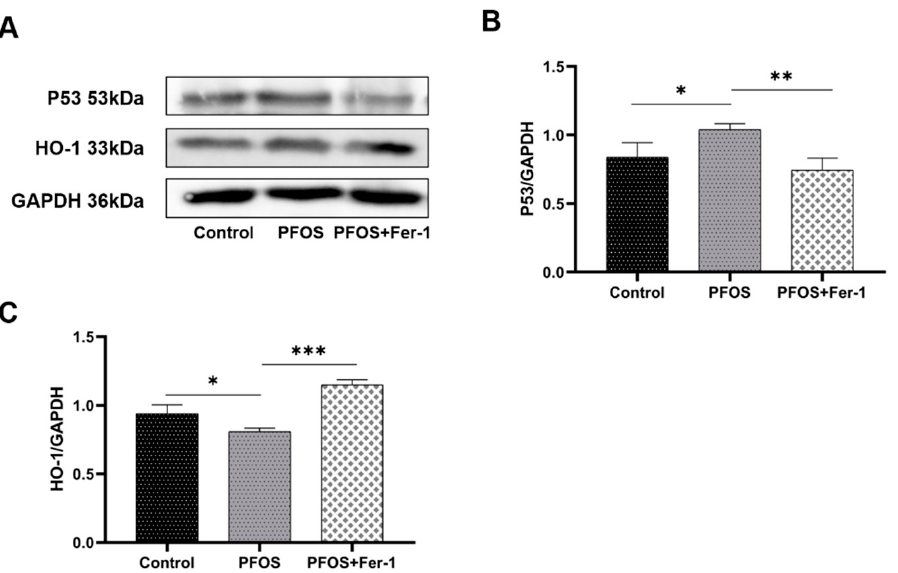
Figure 9. Expression of P53 and HO-1 in HK-2 cells exposed to PFOS or/and Fer-1. HK-2 cells were exposed to PFOS at 200 µ M for 12 h or/and cultured with Fer-1 at 1 µ M for 2 h prior to exposure to PFOS; the results were from three independent experiments. Data were expressed as mean ± SD (n = 3), * p < 0.05, ** p < 0.01, *** p < 0.001. ( A ) Western blot of P53and HO-1; ( B ) comparison of P53 expression among control, PFOS and PFOS+Fer-1 group cells; ( C ) comparison of HO-1 expression among control, PFOS and PFOS+Fer-1 group cells.